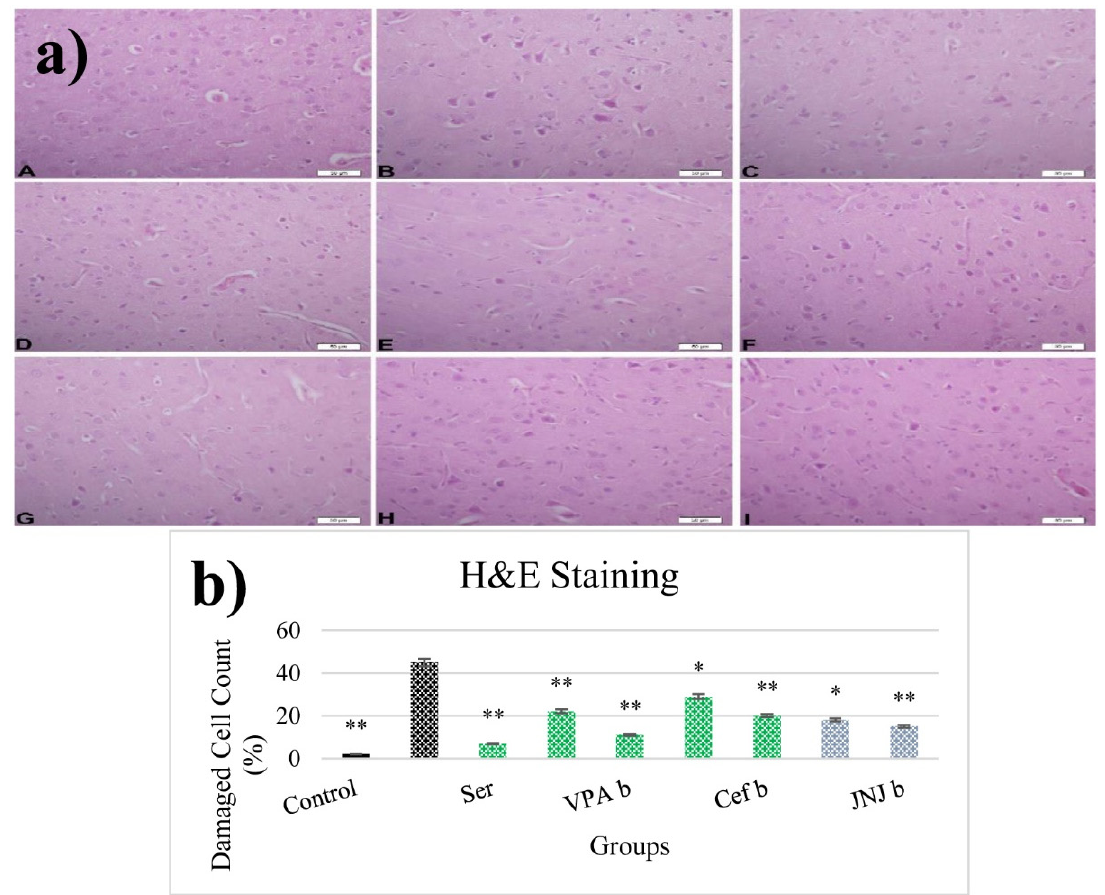
Figure 6. ( a ) H&E images of experimental groups. Histopathological images of A (Control), B (Stress), C (Ser), D (VPAa), E (VPAb), F (Cefa), G(Cefb), H (JNJa), and I (JNJb). ( b ) The number of damaged cells is given as a percentage after quantitative determination. * p < 0.05, ** p < 0.001 compared with the Stress